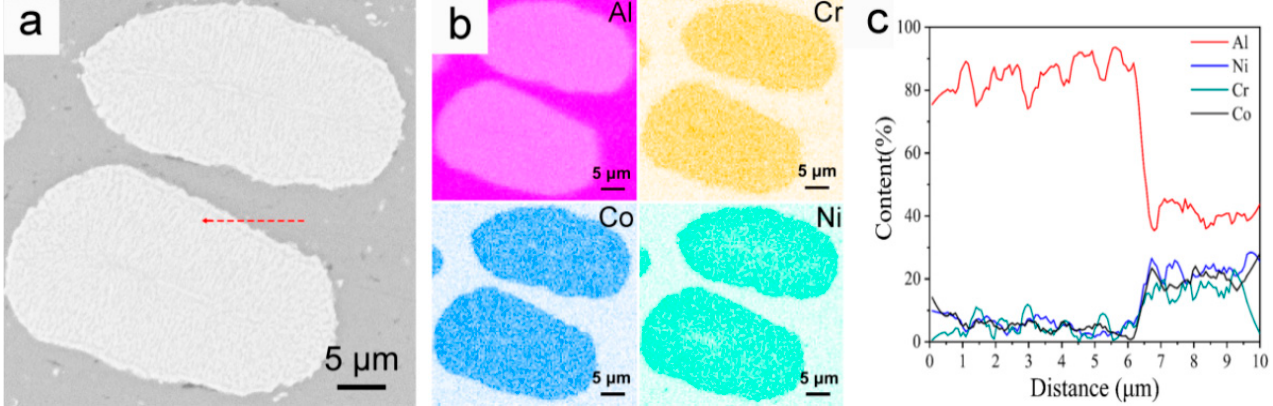
Figure 5. Element distribution around the CrCoNi particles for the 5 wt.% CrCoNi/Al composite. ( a ) SEM image of the selected region, ( b ) elemental mapping images, ( c ) line scanning results (the line scanning track was shown by the red dashed arrow in ( a )).